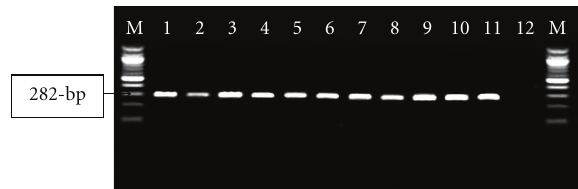
(a) Agarose gel electrophoresis of PCR-amplified omp2 gene fragments specific for Brucella spp. The figure shows a single band, a 282-bp DNA fragment. Lanes: M: molecular 100 size ladder (in base pairs); 1–10: Brucella positive samples for blood and fetal tissues; 11: positive control; 12: negative control.